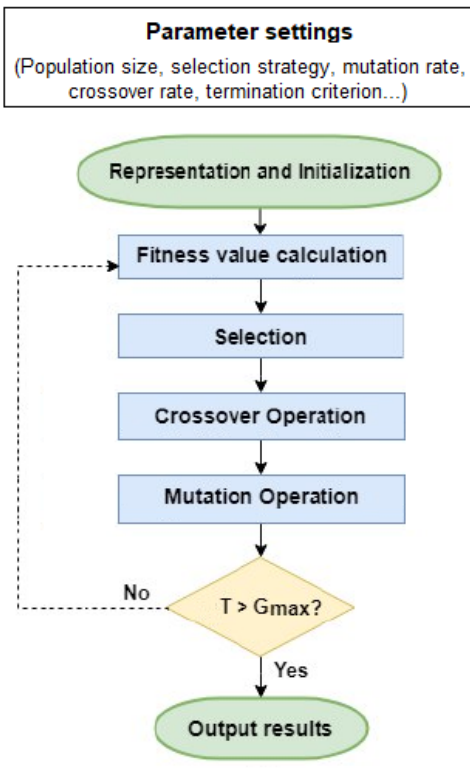
Figure 3. Flowchart of the genetic